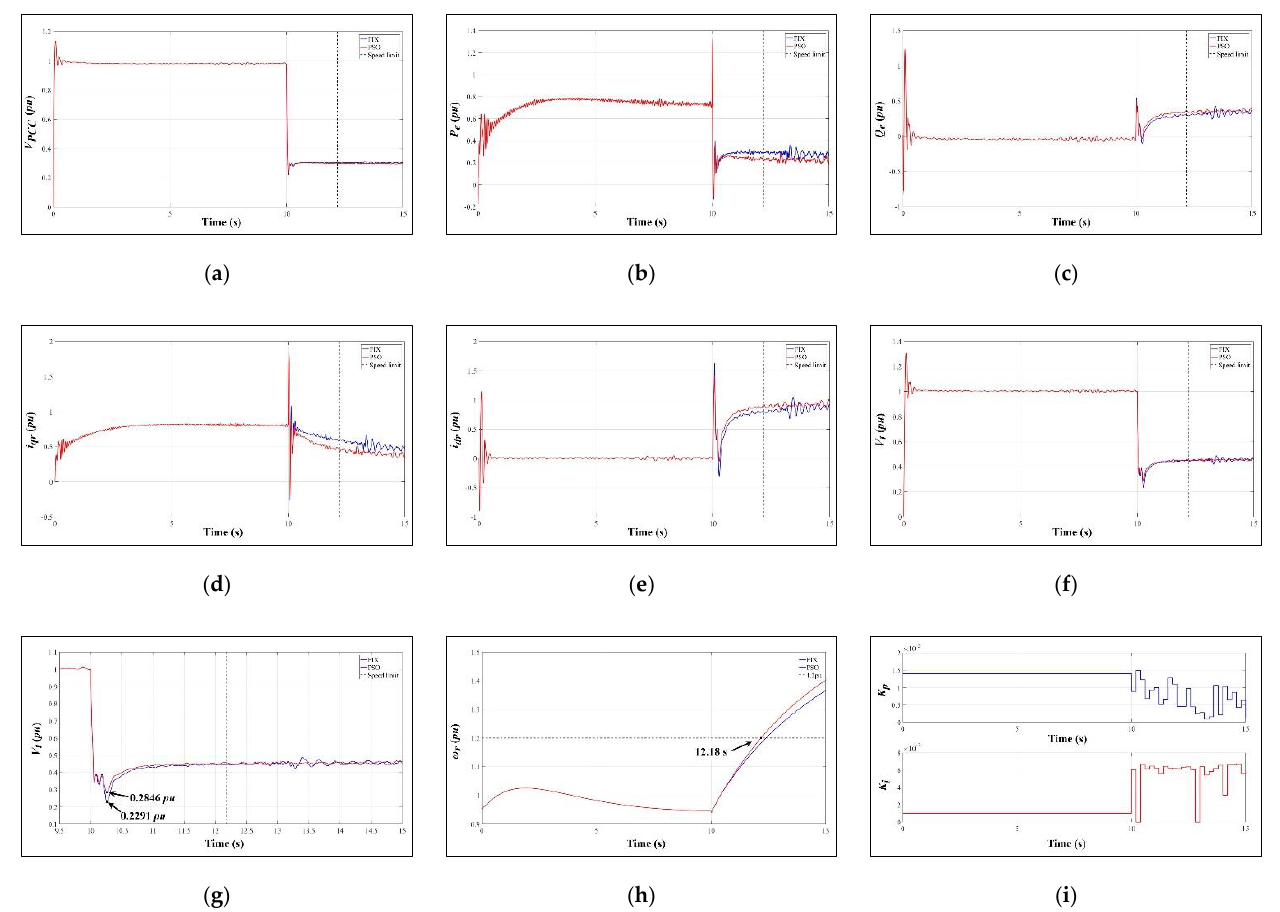
Figure 12. Dynamic response curves for a fault voltage of 0.3 pu . ( a ) Voltage at PCC. ( b ) Wind farm real power. ( c ) Wind farm reactive power. ( d ) q − axis rotor current. ( e ) d − axis rotor current. ( f ) Wind farm terminal voltage. ( g ) Enlarged version of the terminal voltage. ( h ) Generator rotor speed. ( i ) PSO controller gains K p and K i .